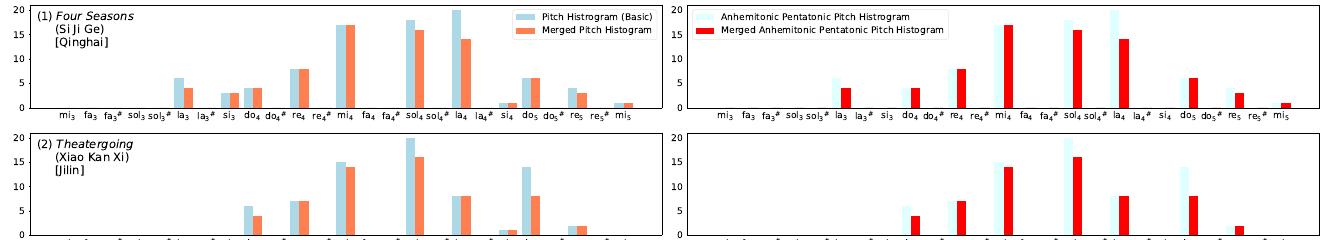
Figure 4. The movable do solfège-based basic pitch histograms and merged pitch histograms for 11 representative traditional Chinese anhemitonic pentatonic folk songs, with the original names (Hanyu Pinyin) in curved brackets and the provinces of the origin in square brackets. The basic pitch histograms ( DoBell < 1) contain individual bins that violate the bell shape, and the merged pitch histograms are all perfect bell-shaped ( DoBell = 1).